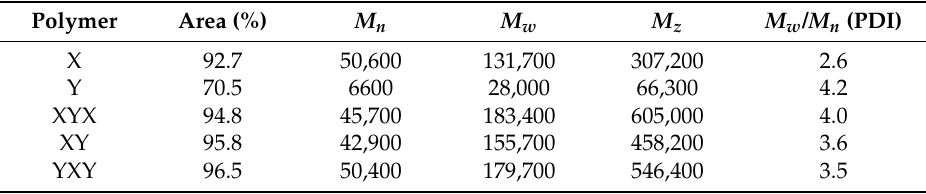
Table 1. GPC analysis of prepared polymers